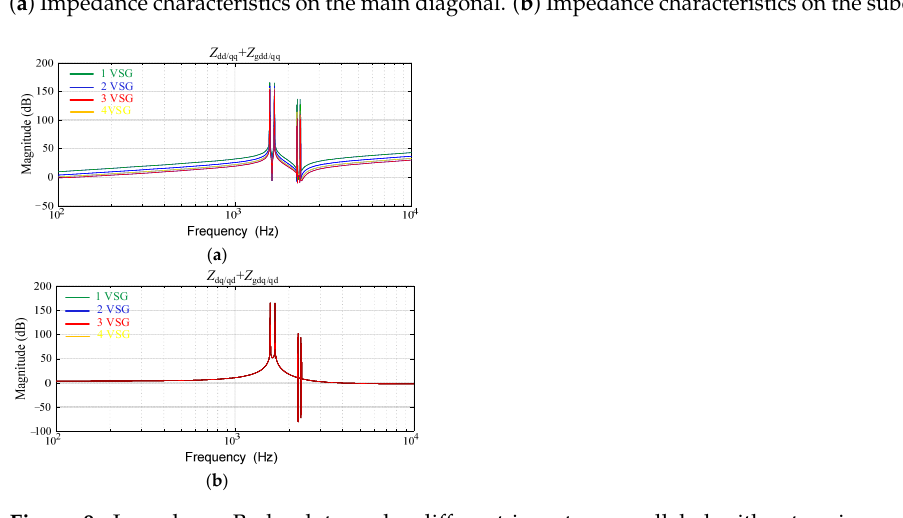
Figure 9. Impedance Bode plots under different inverters paralleled without an inner regulator. ( a ) Impedance characteristics on the main diagonal. ( b ) Impedance characteristics on the subdiagonal.